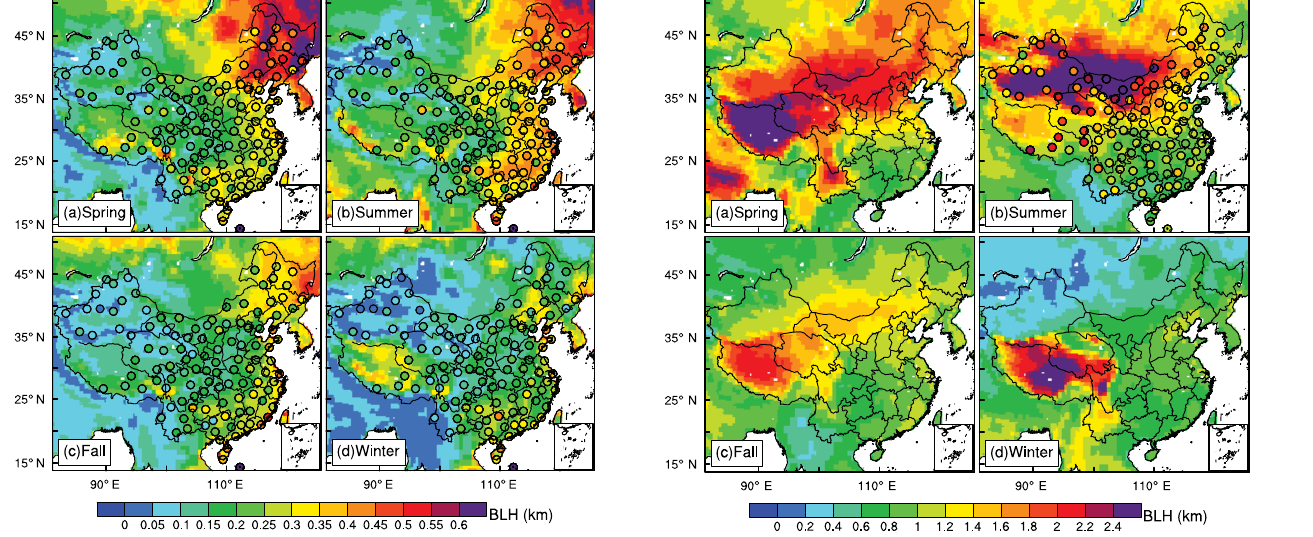
Figure 7. Spatial distributions of the seasonal mean of ERA- BLH (color shaded) and CMA-BLH (color dots) at 08:00BJT in